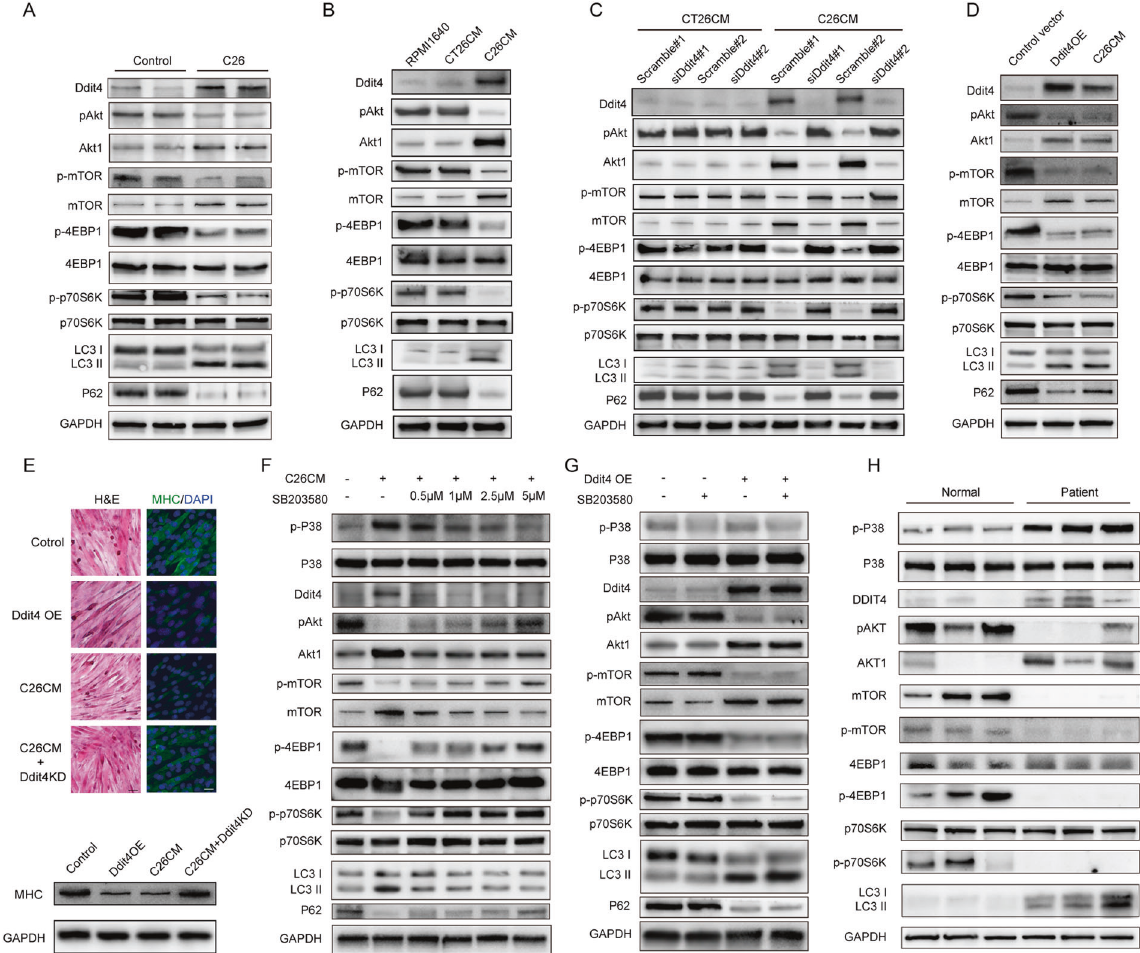
Fig. 7 Knocking down of Ddit4 in C2C12 reversed abnormal mTOR signaling and attenuated autophagy. A Western blot analysis of the expression of the indicated muscle-related genes between normal and cachectic mice. B C2C12 myotubes were treated with RPMI1640, CT26 CM, and C26 CM. Western blot analysis of the indicated genes were detected. C C2C12 myotubes were treated with CT26 CM, CT26 CM plus Ddit4 siRNA (two different siRNA of Ddit4 named #1 and #2) or scramble siRNA, C26 CM, C26 CM plus Ddit4 siRNA (two different siRNA of Ddit4 named #1 and #2) or scramble siRNA for 24 h. Western blot analysis of the indicated genes in C2C12 cells with Ddit4 knockdown and/or C26 CM challenge. D C2C12 myotubes were treated with control vector, Ddit4 overexpression plasmid, or C26 CM for 24 h. E Upper panel: the morphological changes in C2C12 myotubes were addressed by H&E staining (left panel). C2C12 cells were immunostained with the MHC (MF20) antibody. MHC, green, DAPI, blue (right panel). Scale bar: 50 μ m. Lower panel: Western blot analysis of MHC in C2C12 myotubes. F C2C12 cells were pretreated with ( + ) or without ( − ) SB203580(0.5, 1, 2.5, and 5 µM) prior to C26 CM for 24 h. Cell lysates were subjected to Western blot analysis; G C2C12 cells were pre-treated with ( + ) or without ( − ) SB203580 (5 µM) and then transfected with Ddit4-overexpressing plasmid. Cell lysates were subjected to Western blot analysis. H Western blot detection of the indicated genes in the muscle of healthy people and the muscle of liver cancer patients with